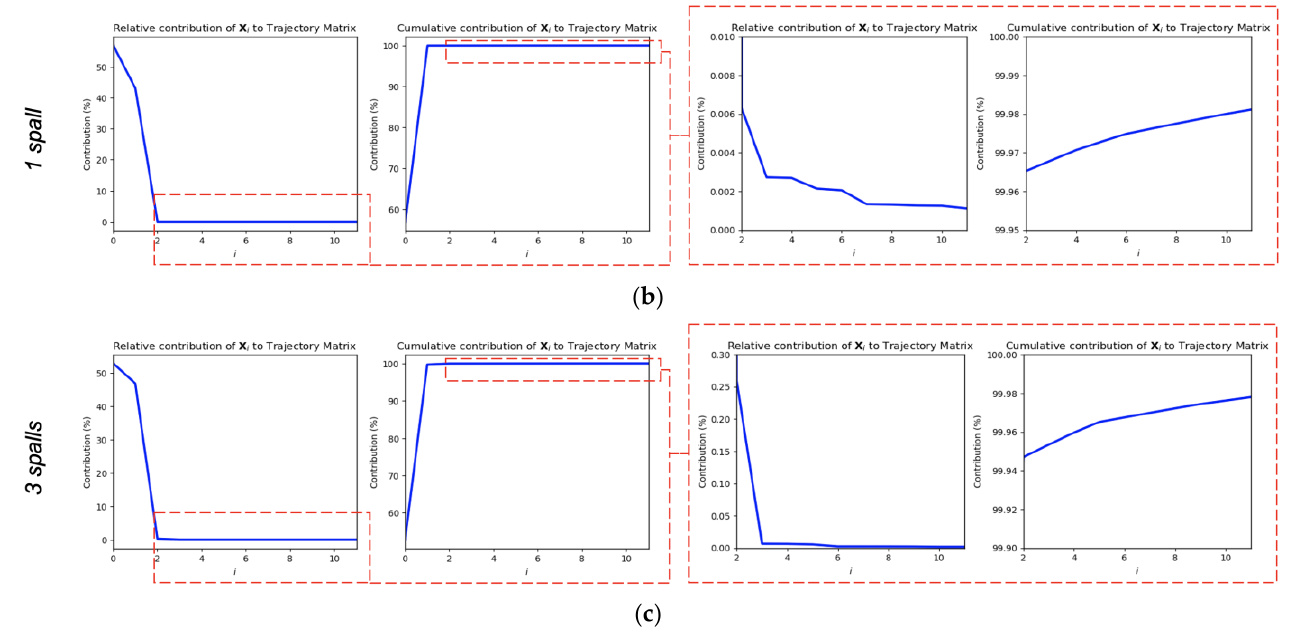
Figure 8. Relative and cumulative contribution of the components: [0, …, 11] (left), [2, …, 11] (right) for phase A of the bearing without faults ( a ), the bearing with one spall ( b ) and the bearing with three spalls ( c ).